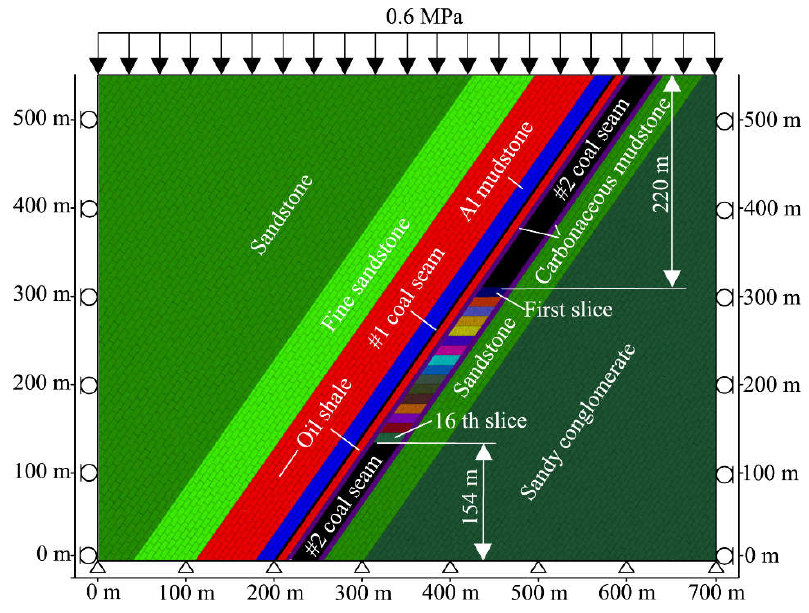
Figure 3. Geometric model. Table 1. Physical and mechanics properties of the rocks and coal blocks.